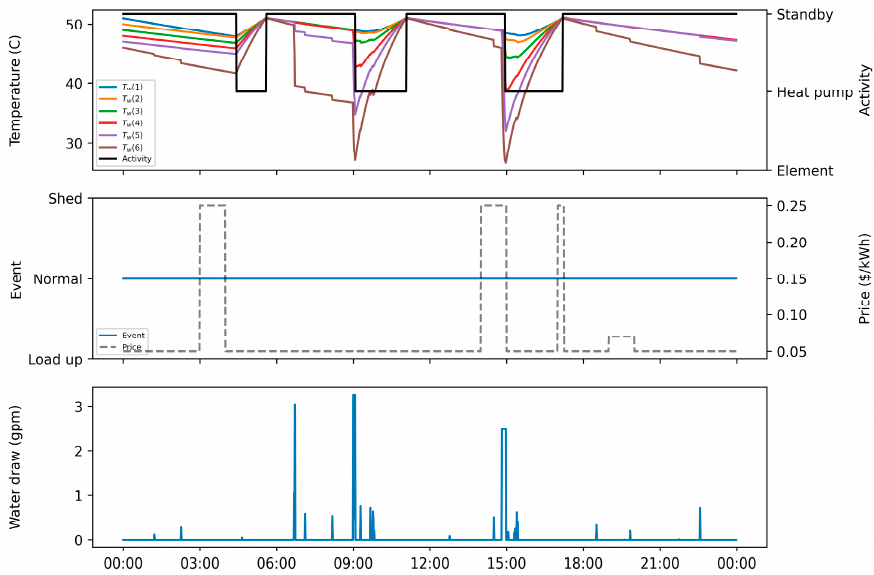
Figure 7. Baseline Figure 7. Baseline operation.